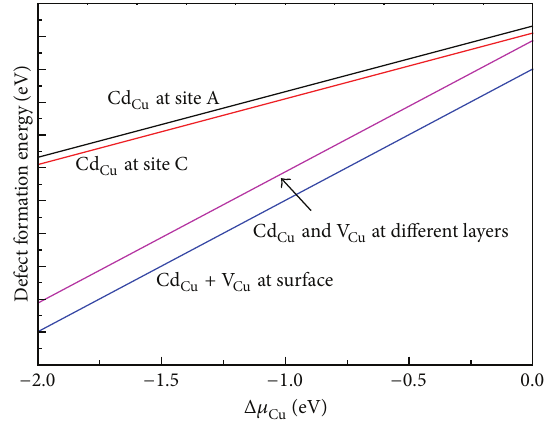
Figure 4: Defect formation energies versus the relative chemical = 0 corresponds to Cu-rich conditions and . Δ𝜇 potential Δ𝜇 Cu Cu = −2.0 corresponds to Cu-poor conditions. Here we do not Δ𝜇 Cu consider the variation of chemical potential of the Cd